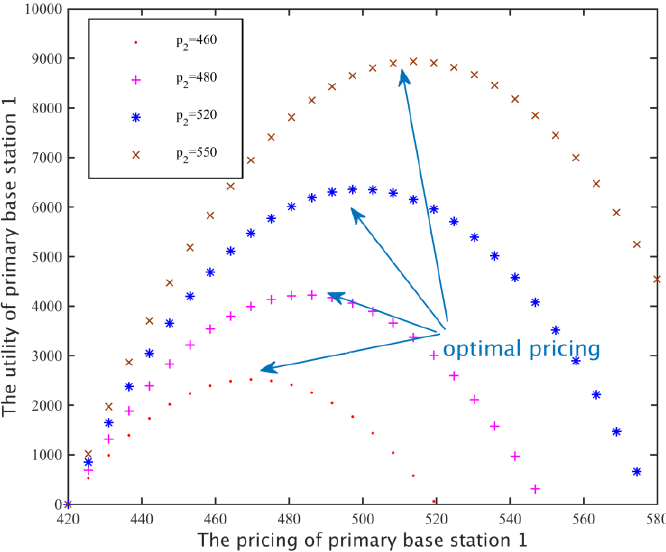
Figure 7. Utility function of a primary base station.